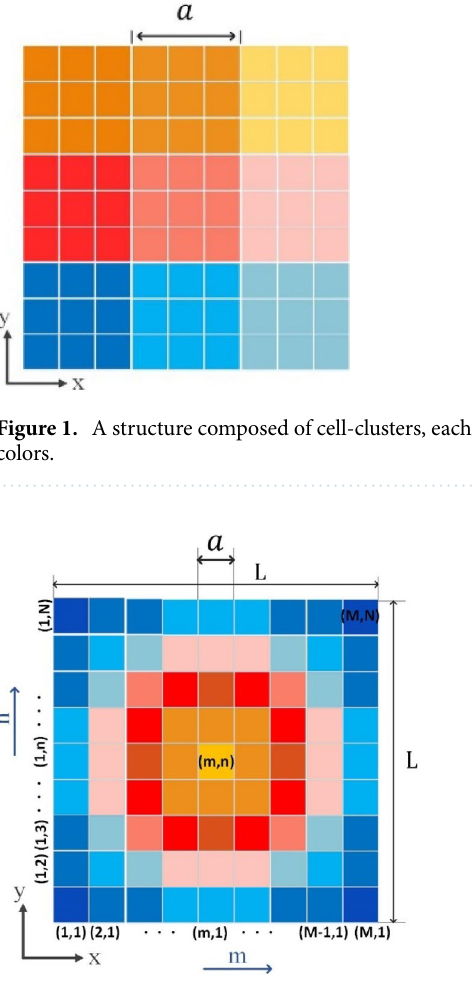
Figure 2. The conceptual schematic of a reflector surface consisting of